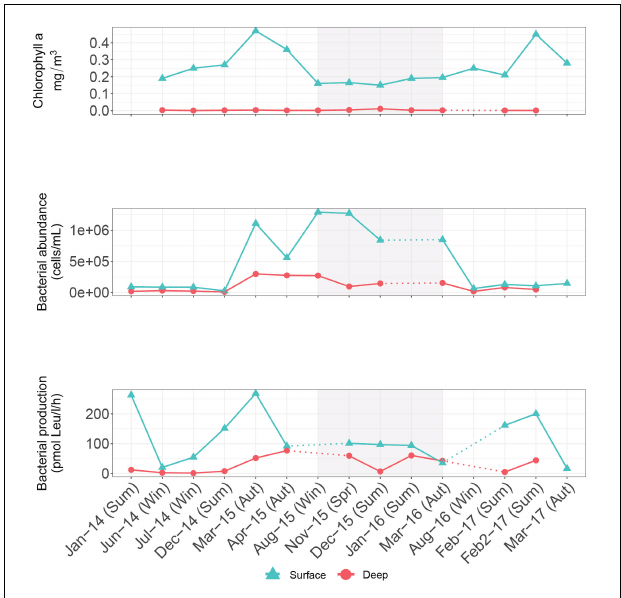
FIGURE 1 | A 3-year time-series of subantarctic surface and deep (500 m) water chlorophyll- a , prokaryotic abundance and heterotrophic production samples taken from the Munida Microbial Observatory Time-Series (MOTS). Shaded area shows period of El Niño, dashed lines indicate missing data and meteorological seasons are indicated for each sampling date: Spr, spring; Sum, summer; Aut, autumn; Win,